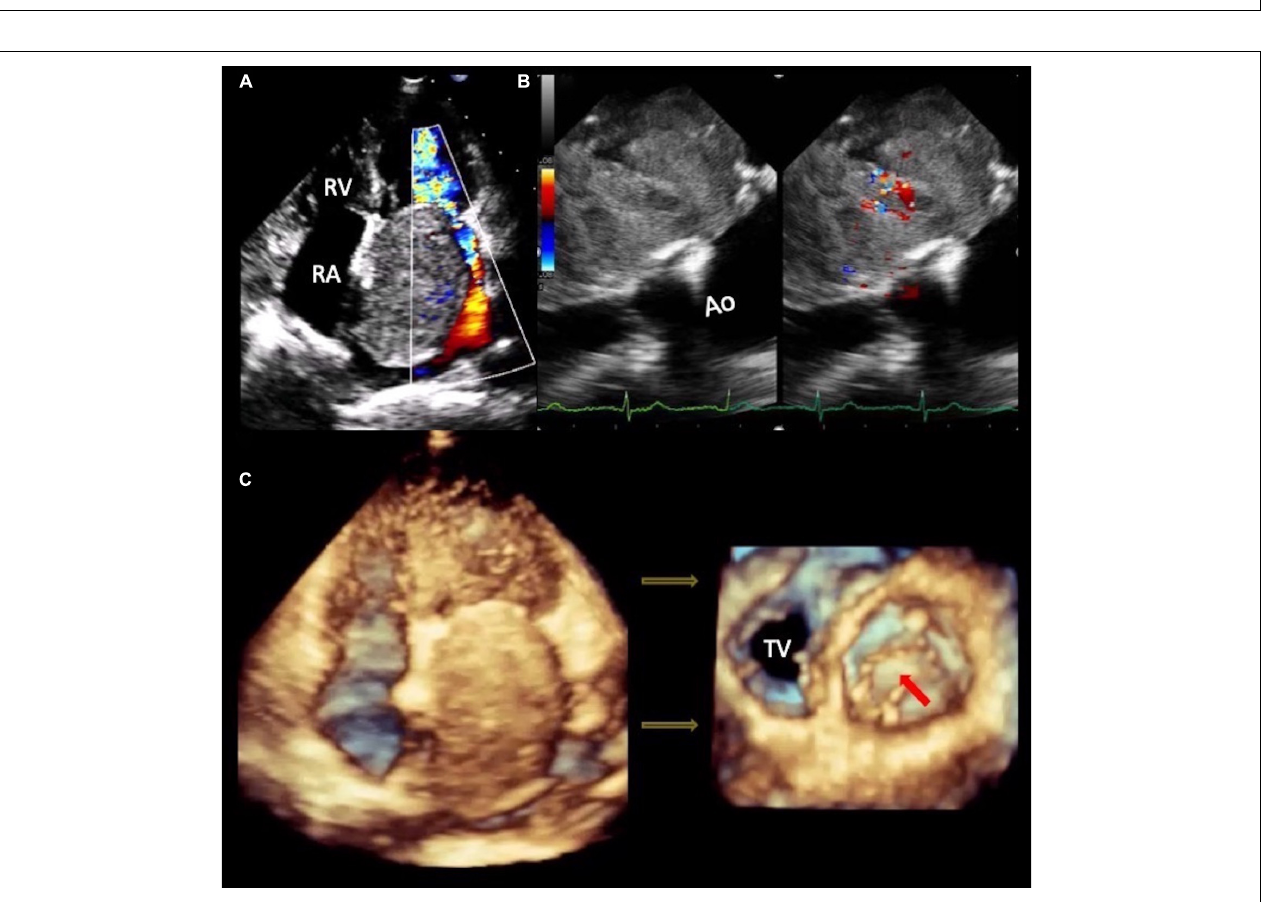
FIGURE 2 | Echocardiogram. (A) 2D-TTE four-chamber view shows a large echogenic oval mass that occupies practically the entire left atrium, with regular borders, heterogeneous echogenicity, adhered to the interatrial septum by a short pedicle and moderate to severe mitral regurgitation in the color Doppler. (B) 2D-Transesophageal echocardiogram and color-Doppler evidenced significant vascularization inside the mass. (C) 3D-TTE shows the mass protruding through the mitral valve into the left ventricle during end-diastole ( Supplementary Video 2 ). Ao, aorta; RA, right atrium; RV, right ventricle; TTE, transthoracic echocardiogram; TV, tricuspid